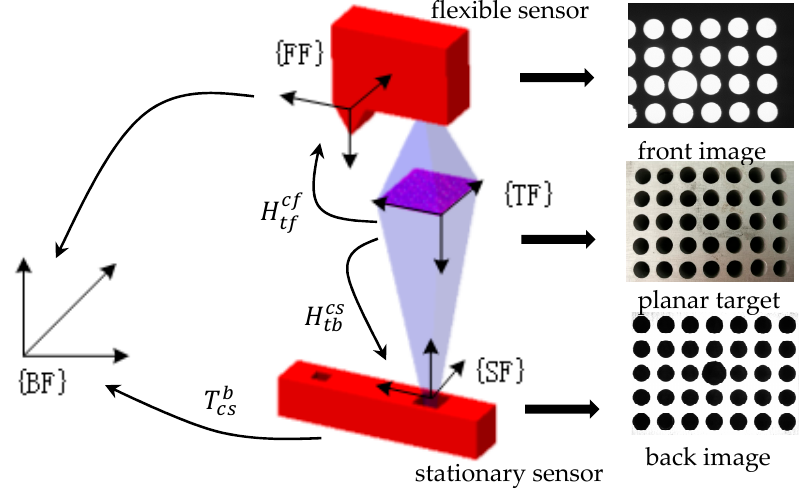
Figure 3. Principle of the stationary sensor global calibration.